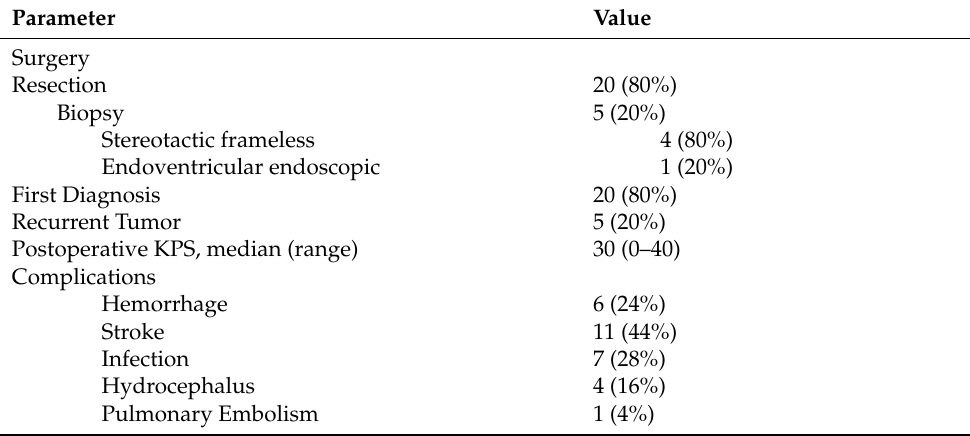
Table 2. Clinical and surgical features.